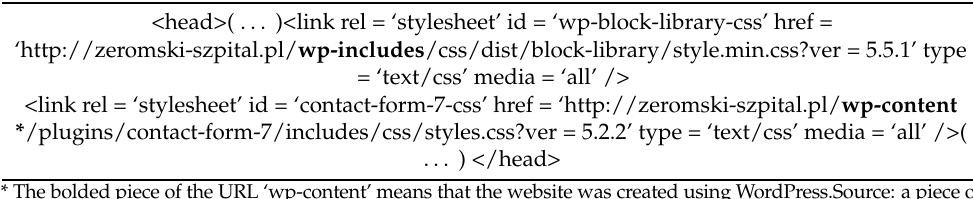
Table 3. A piece of source code of a